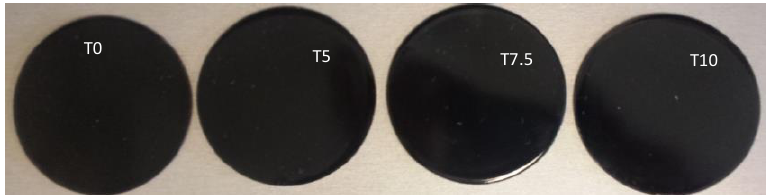
Figure 1. Digital pictures of the ground coat enamel with silica addition fired at 840 °C for 4 min in air.